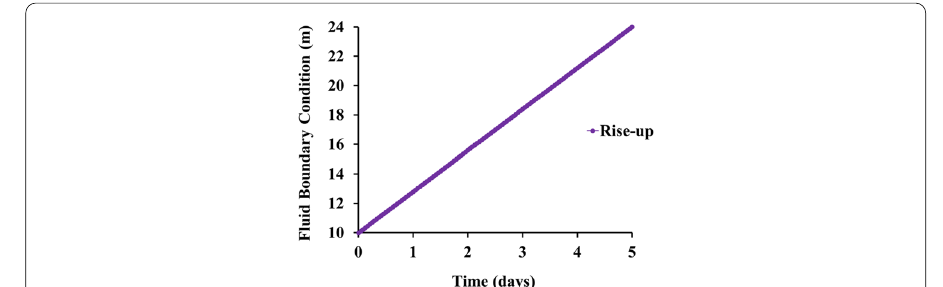
Fig. 11 Reservoir rise-up (RU) condition and rate adopted in the present analysis